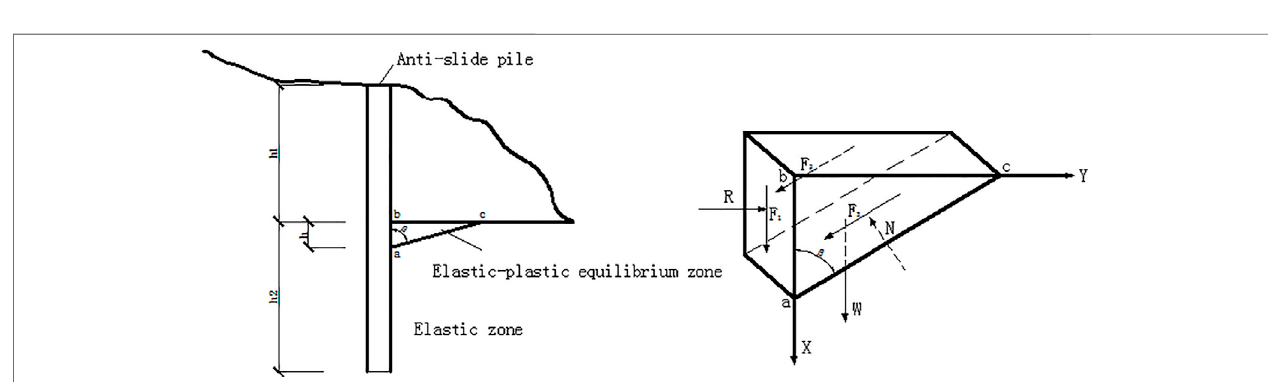
FIGURE 2 | Stress diagram of the anti-slide pile and the wedge model in the elastic-plastic equilibrium zone.